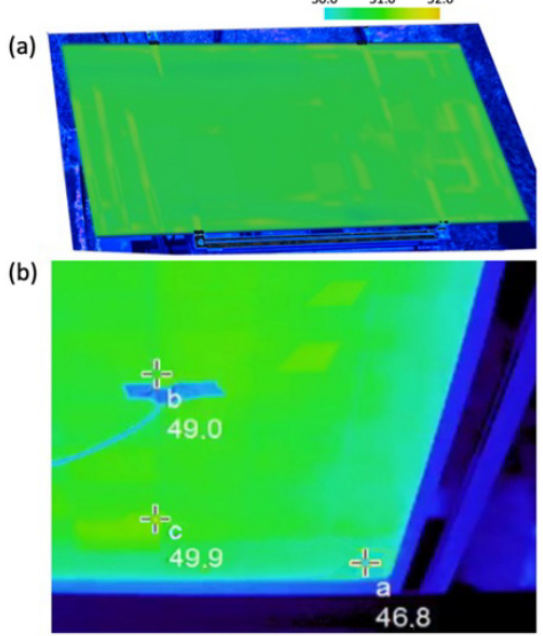
Figure 10. Representative thermographic scans of ( a ) CdTe module, and ( b ) Si module under normal operating ambient conditions, indicting more prevalent temperature areal variations for the Si module because of framing and mismatched cells in the strings.